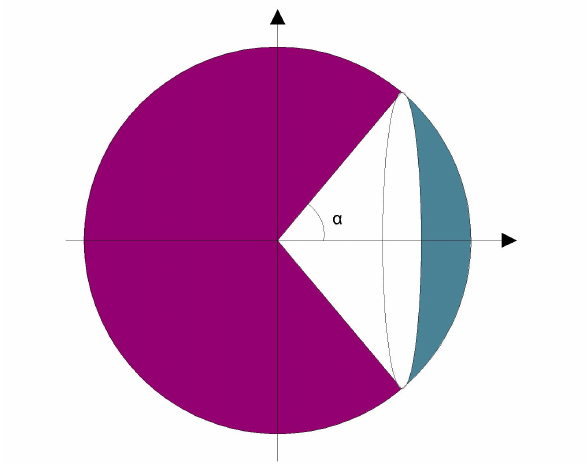
Figure 3. Sphere and cone with its apex on the center of the